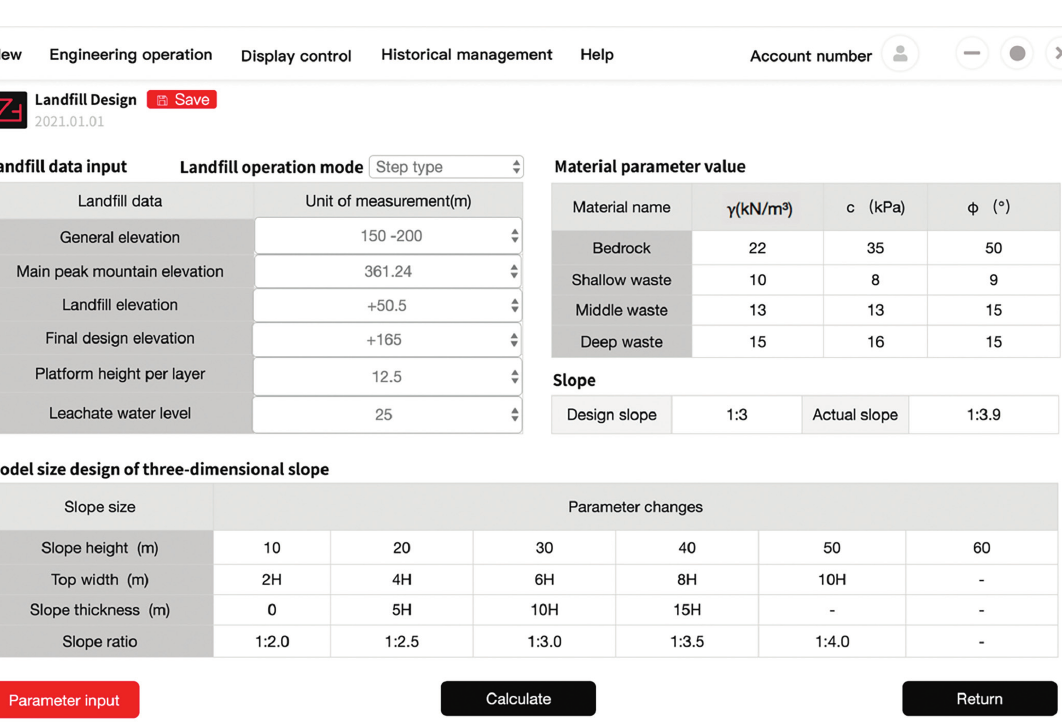
Figure 3: Landfill